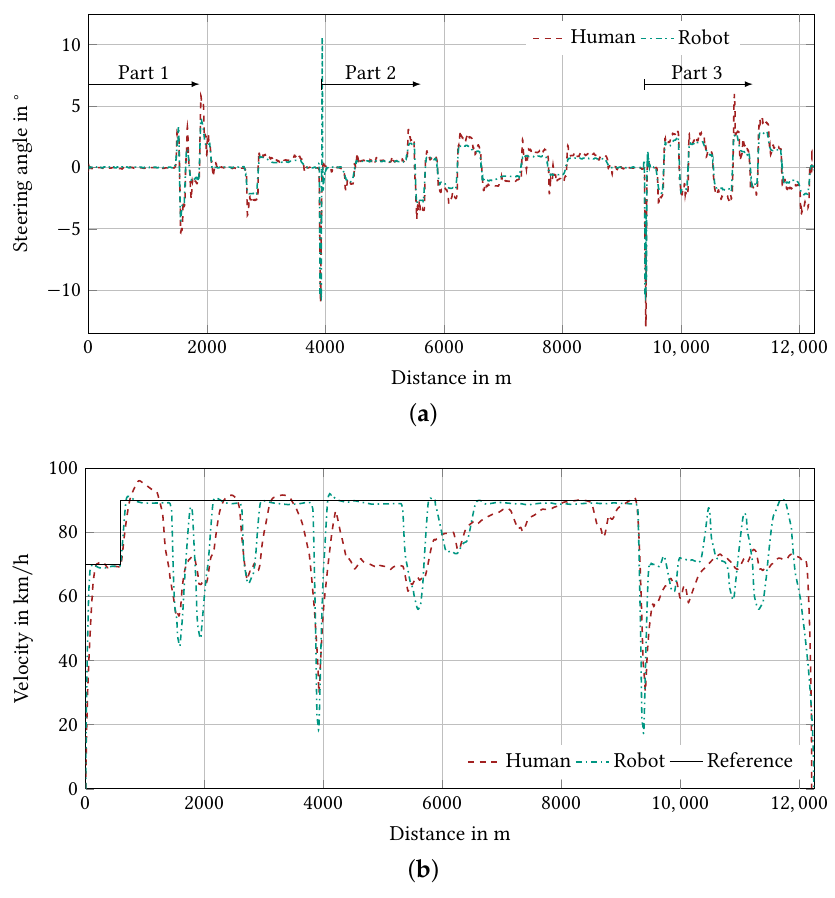
Figure 10. Steering angle and velocity comparison of the human driver and the driving robot. ( a ) Steering angle comparison, ( b ) Velocity